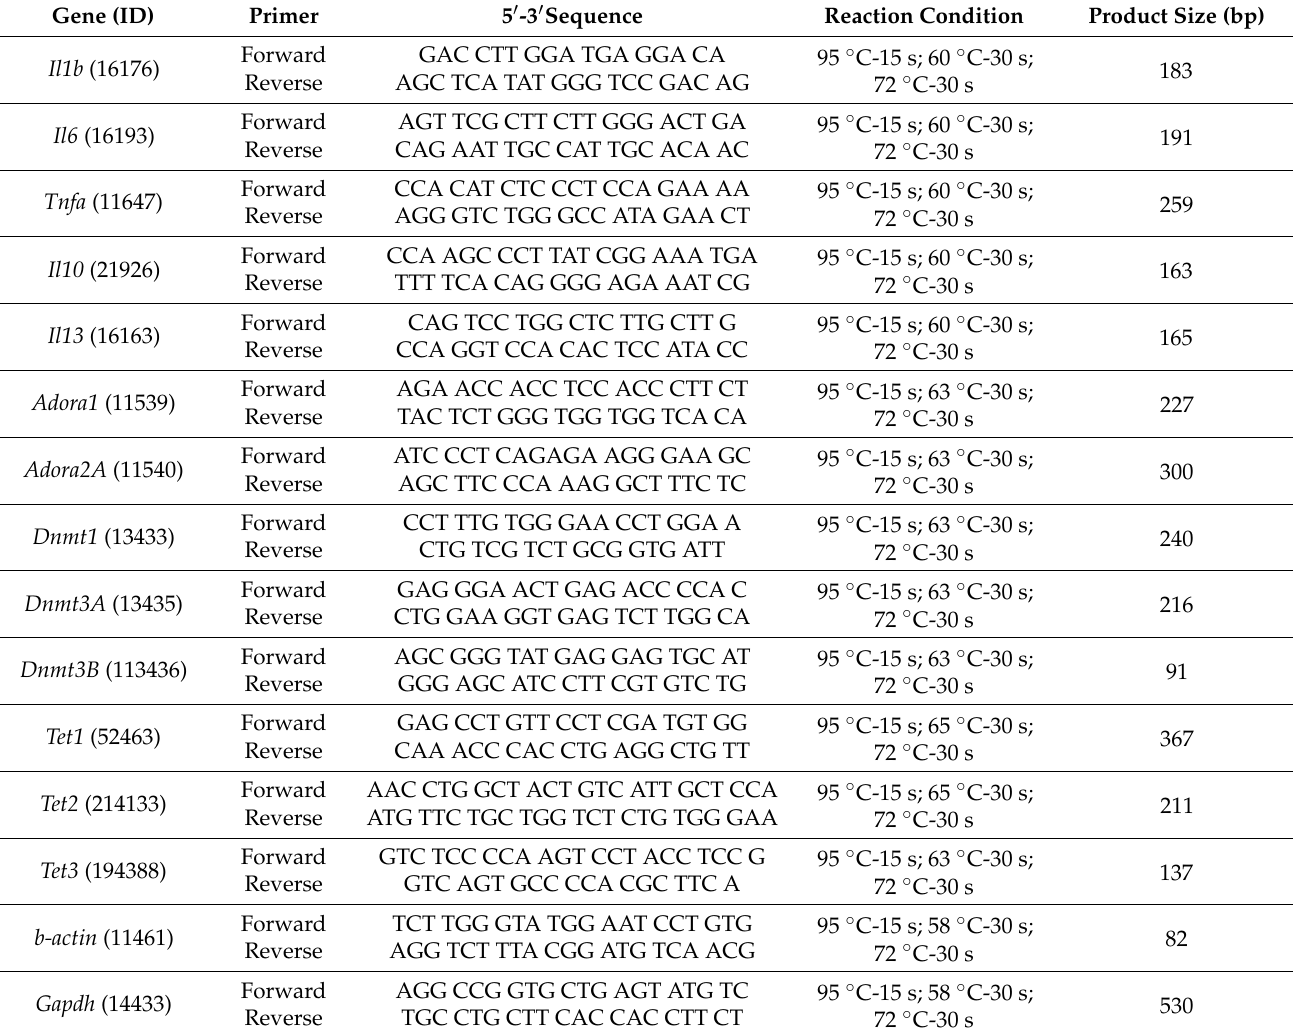
Table 1. Oligonucleotide primers and PCR conditions used in quantitative real-time